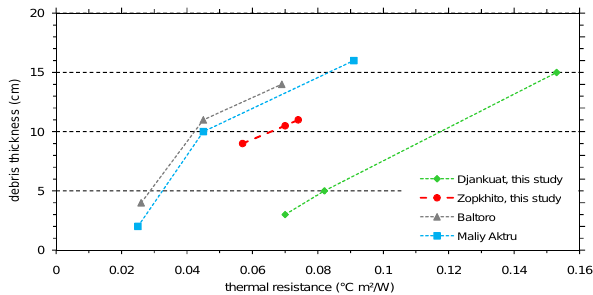
Fig. 11. Thermal resistance for the glaciers in the Caucasus and Altai and compared with results from former field measurements in the